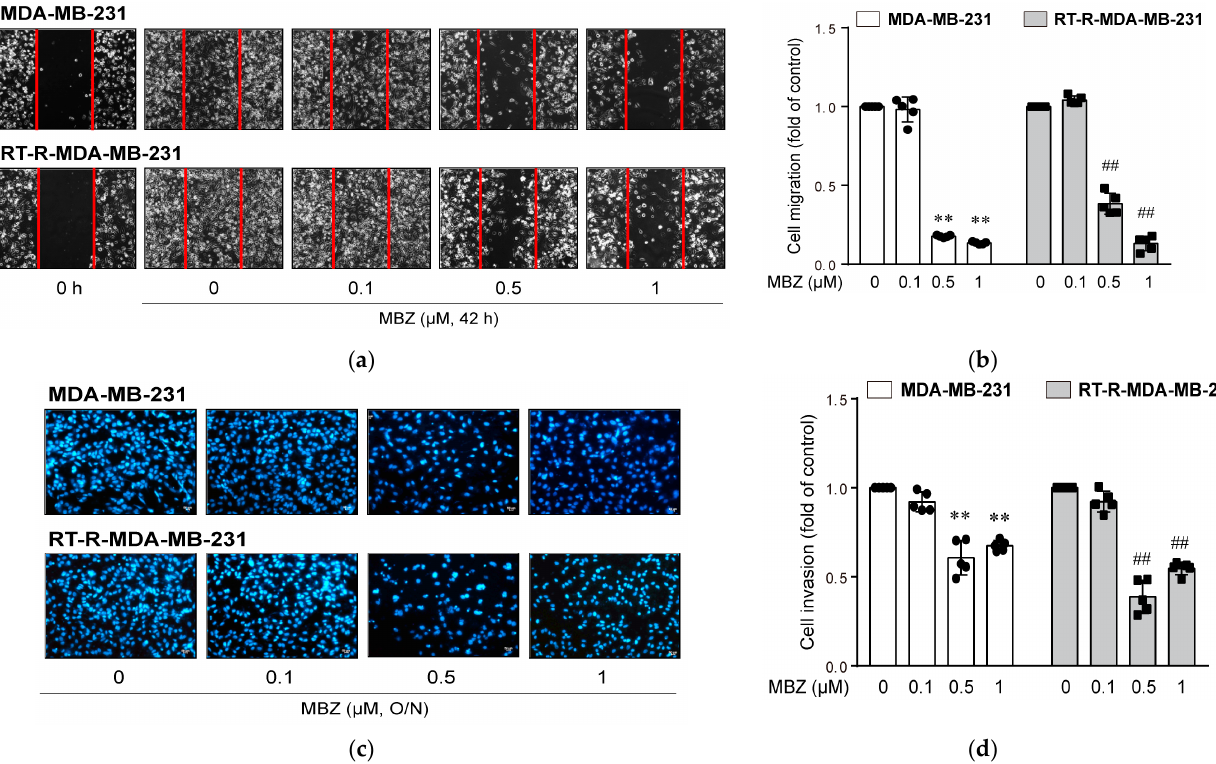
Figure 5. MBZ significantly reduces migration and invasion of MDA-MB-231 and RT-R- MDA-MB-231 cells at 0.5 and 1 µ M. ( a , b ) MDA-MB-231 and RT-R- MDA-MB-231 cells were seeded in 6-well plates, and treated with MBZ (0.1, 0.5, and 1 µ M), until wounds in control group without MBZ closed for 42 h. Then, the migrated cells were quantified under a microscope after wound scratching. The data represent the mean ± SD of five independent experiments. ( c , d ) MDA-MB-231 and RT-R- MDA-MB-231 cells were added to EC-Matrigel-coated insert wells and incubated overnight at 37 °C. The cells that had invaded across the membrane were stained with DAPI and counted in five randomly selected fields under a fluorescence microscope. The data represent the mean ± SD of five independent experiments. ** p < 0.01, ## p < 0.01.